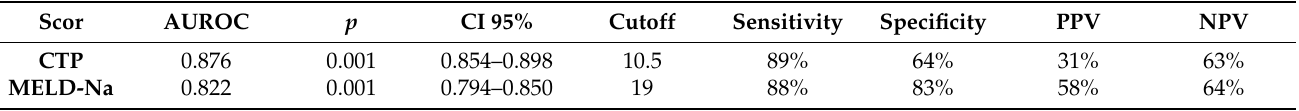
Table 3. Performance of predicting scores (CTP and MELD-Na)—first hospitalization.